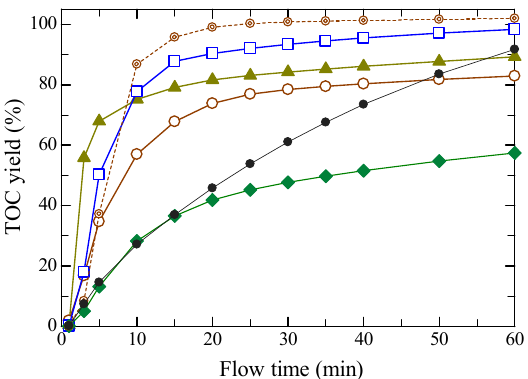
Figure 1. Comparison of the effects of ionic liquids (ILs) on time change in TOC yield from hydrothermal hydrolysis of regenerated solid filter paper, which was obtained as follows: dissolution with IL at 373 K for 120 min or bis(ethylenediamine ammonium) copper (BEDC) at room temperature for 30 min, precipitating by adding water, washing and then drying. Hydrolysis condition was at 533 K and 5.0 MPa by flowing water at 15.0 mL/min. ILs used for dissolving filter paper are: : BEDC, : untreated .